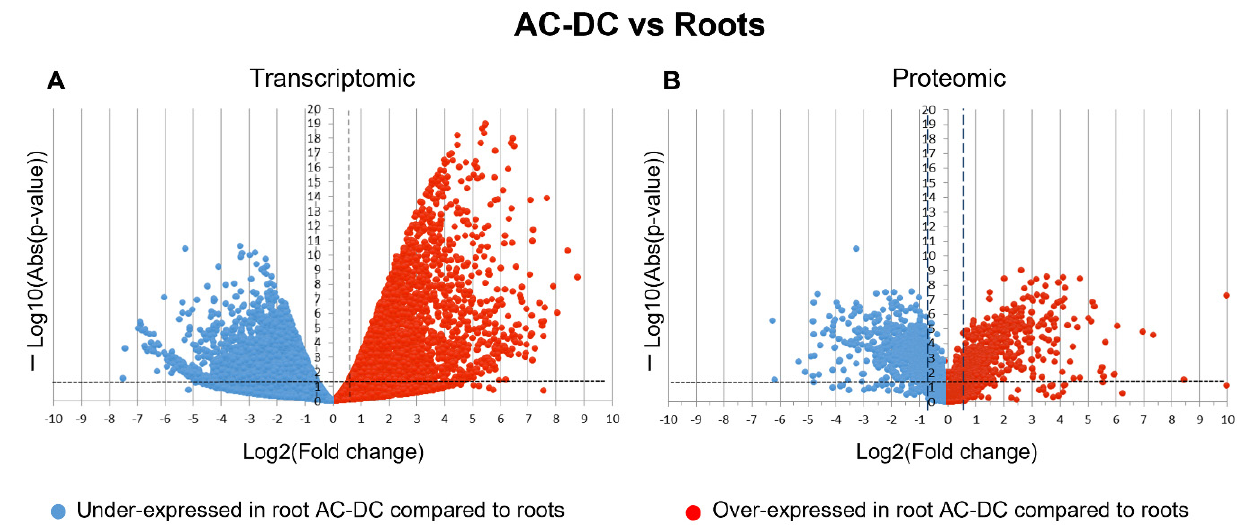
Figure 1. Differential expression analysis of genes ( A ) and proteins ( B ) in root AC-DC and roots. These volcano plots were obtained from transcriptomic ( A ) and proteomic ( B ) data. Blue points correspond to genes ( A ) and proteins ( B ) under-expressed in root AC-DC compared to roots. Red points correspond to genes ( A ) and proteins ( B ) over-expressed in root AC-DC compared to roots. The number of under- and over-expressed genes and proteins for each method appears in blue (under-expressed) and red (over-expressed) squares. DEG = differentially expressed genes; DEP = differentially expressed proteins (fold change ≤ 0.66 or fold change ≥ 1.5; p -value ≤ 0.05).